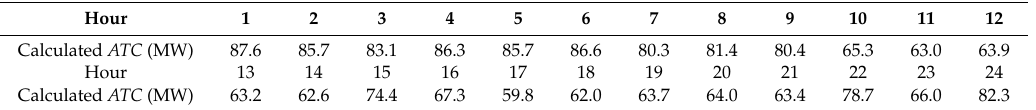
Table 3. Calculated available transfer capacity ( ATC ) values for the critical line.